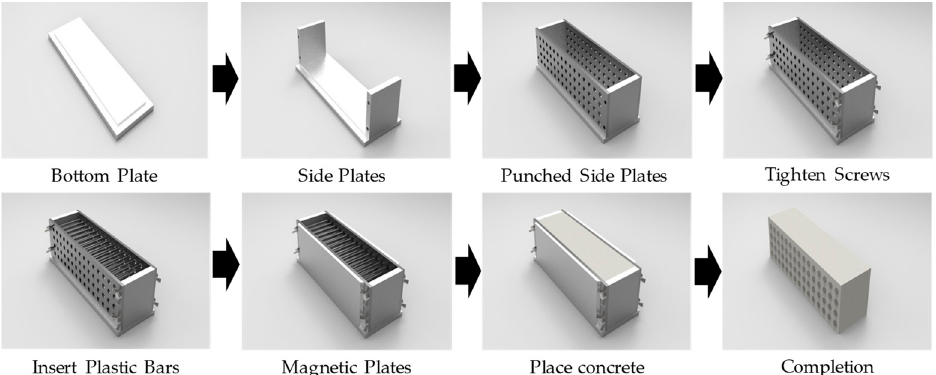
Figure 1. Procedure of transparent plastic bar reinforced concrete [17,19].